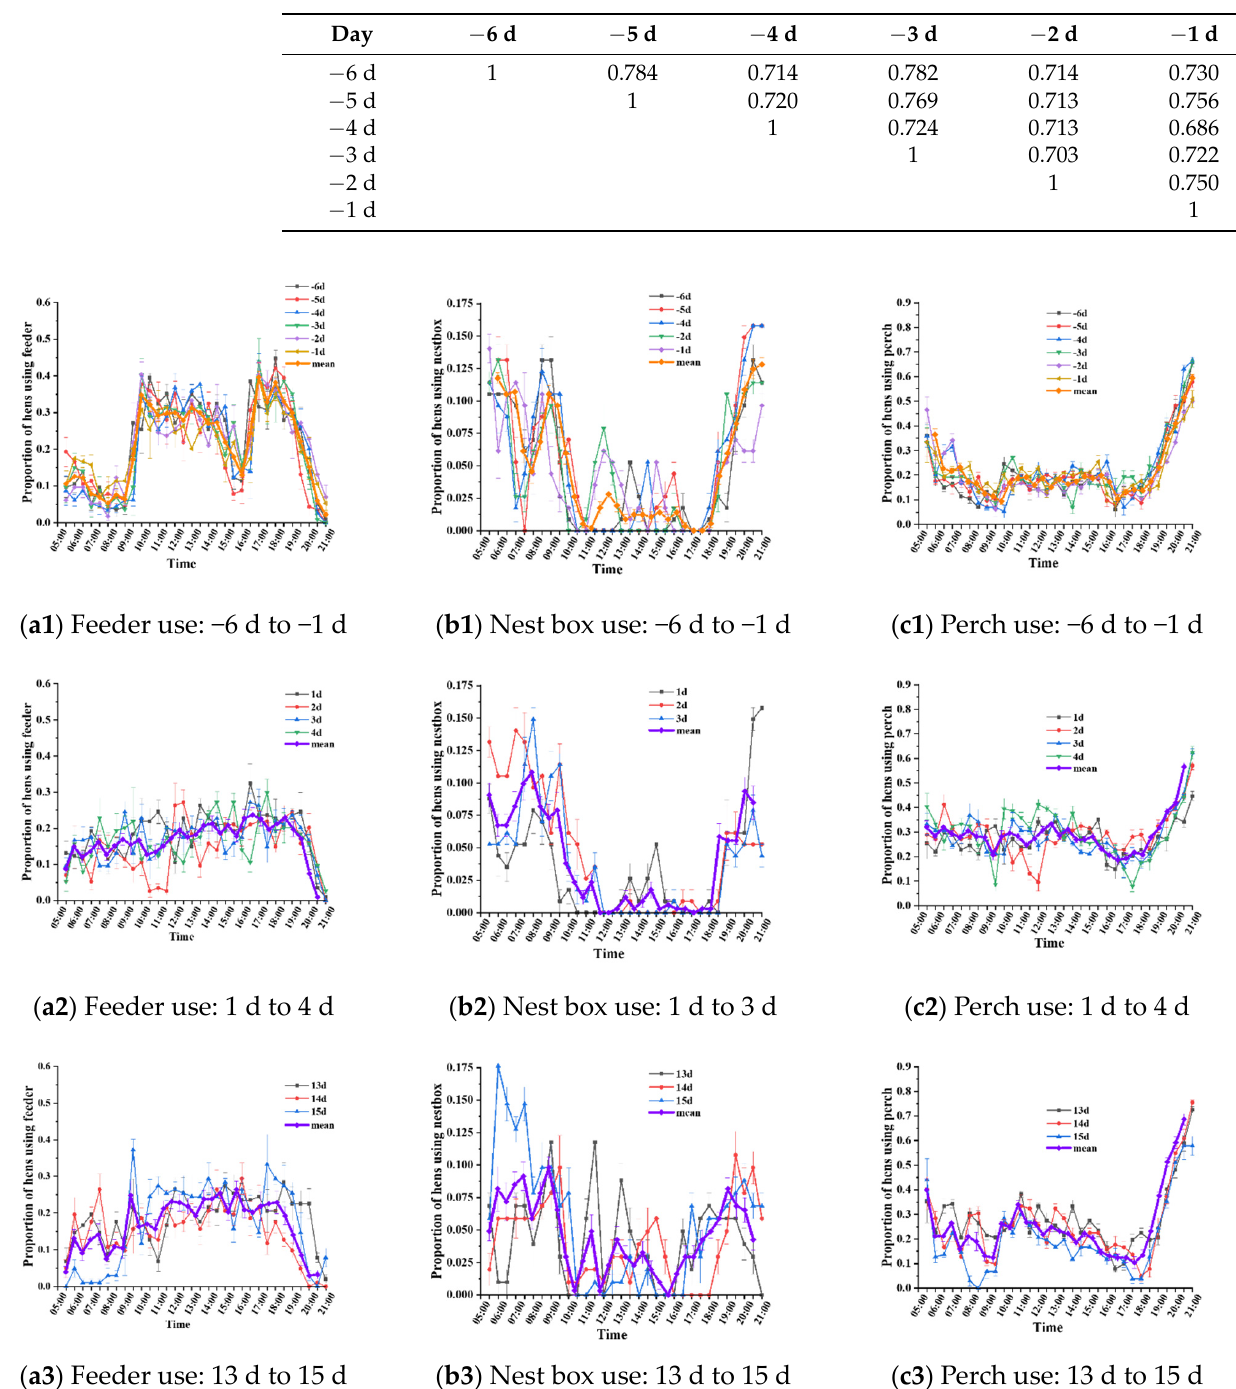
Table 4. The Euclidean Distance (ED) score for the diurnal pattern of hens using the perch for each day from − 6 d to − 1 d.